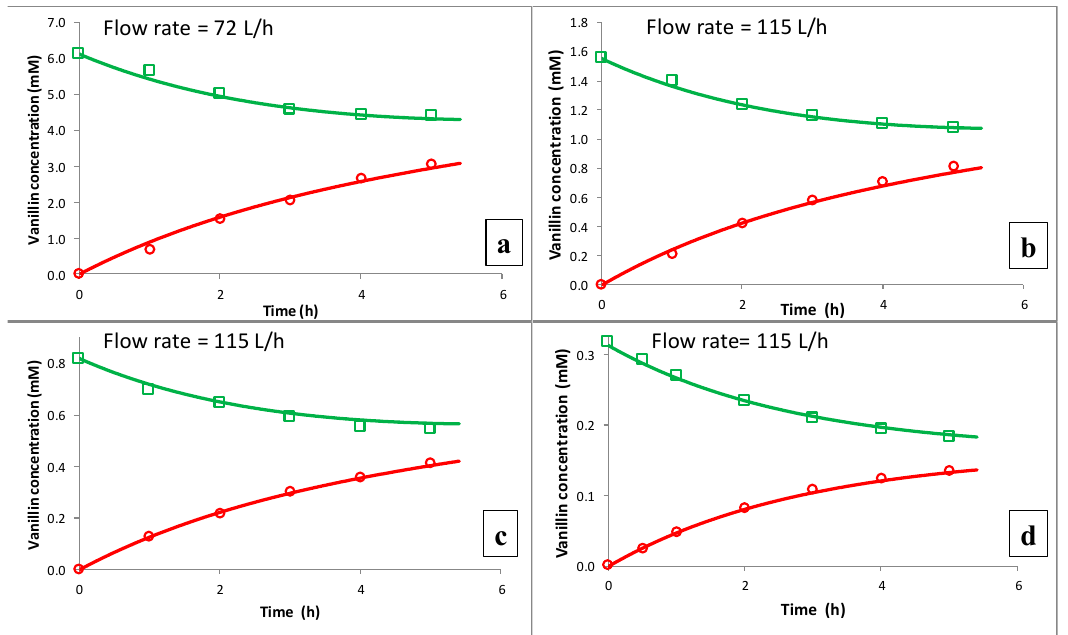
Figure 6. The fitting of the experimental data (dots) by the mathematical model (lines) for some experimental runs at different initial vanillin concentration in Liquid 1. Upstream data (green) and downstream data (red). Upstream initial concentrations: ≈ 6 mM ( a ); ≈ 1.6 mM ( b ); ≈ 0.8 mM ( c ); and ≈ 0.3 mM ( d ). Flow rates for Liquid 1 are indicated in the figure. Flow rates for Liquid 2 = 75 L/h ( a – d ).